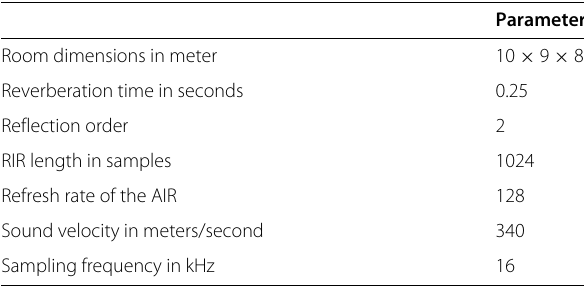
Table 1 Parameter setup